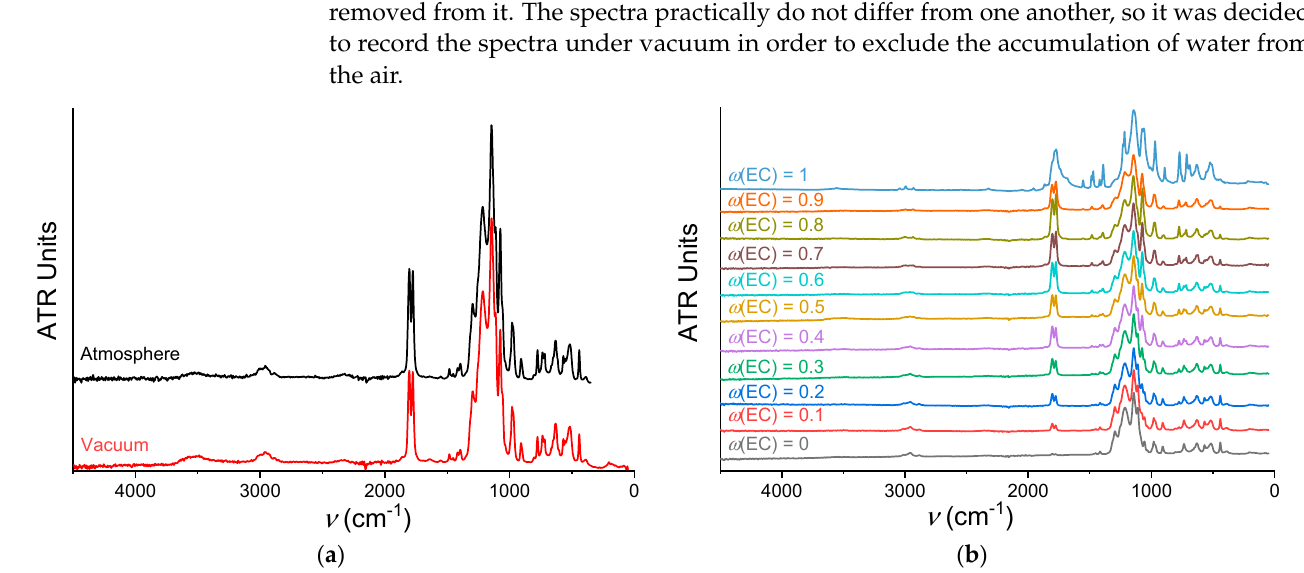
Figure 8. The survey FTIR ATR spectra of swollen Na-Nafion membranes: ( a ) recorded at various conditions ( ω (EC) = 0.5, T sw = 40 ◦ C); ( b ) with various ω (EC); swollen at 40 ◦ C and swollen at 40 and 60 ◦